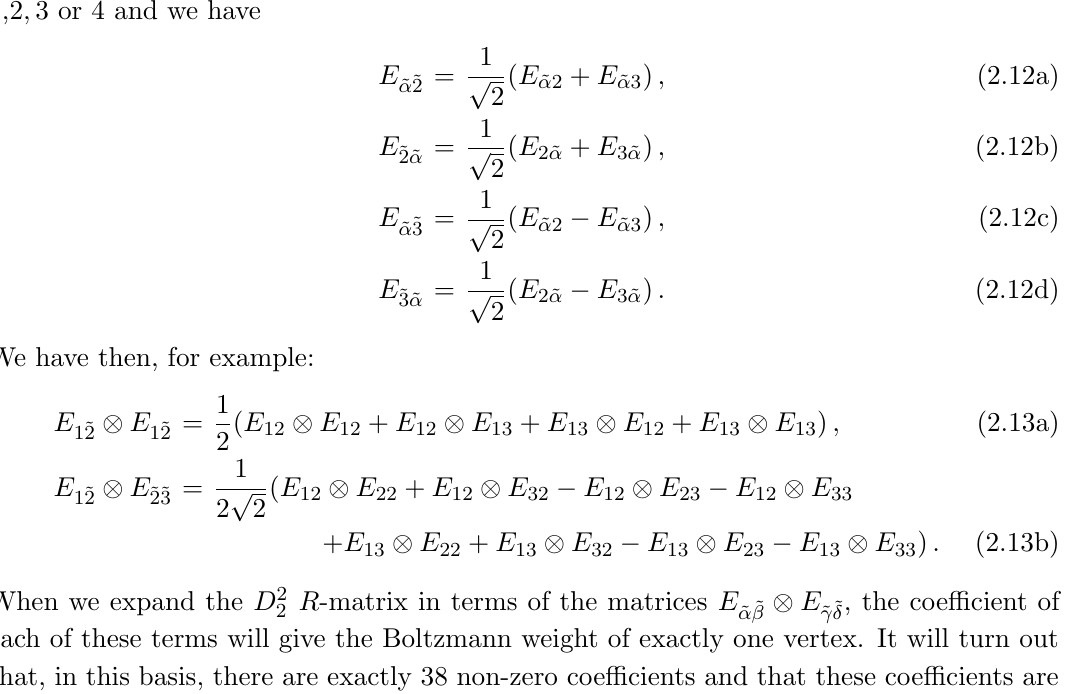
Figure 5 . Labelling around a vertex in the D 2